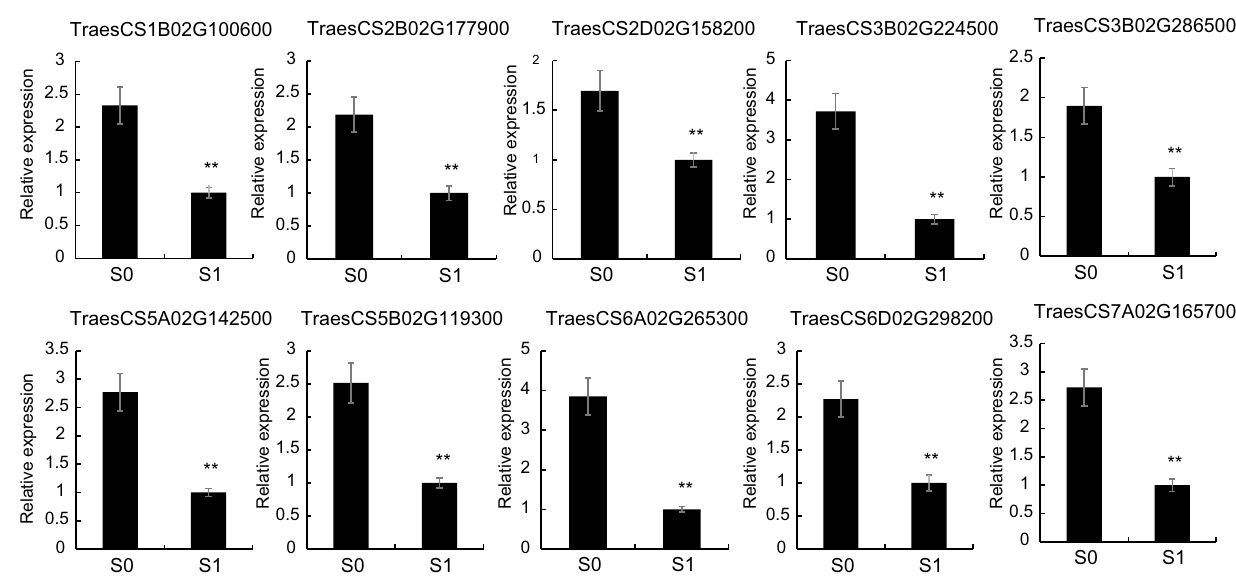
Figure 5. Expression profiles of 10 randomly selected differentially expressed MYB TFs by